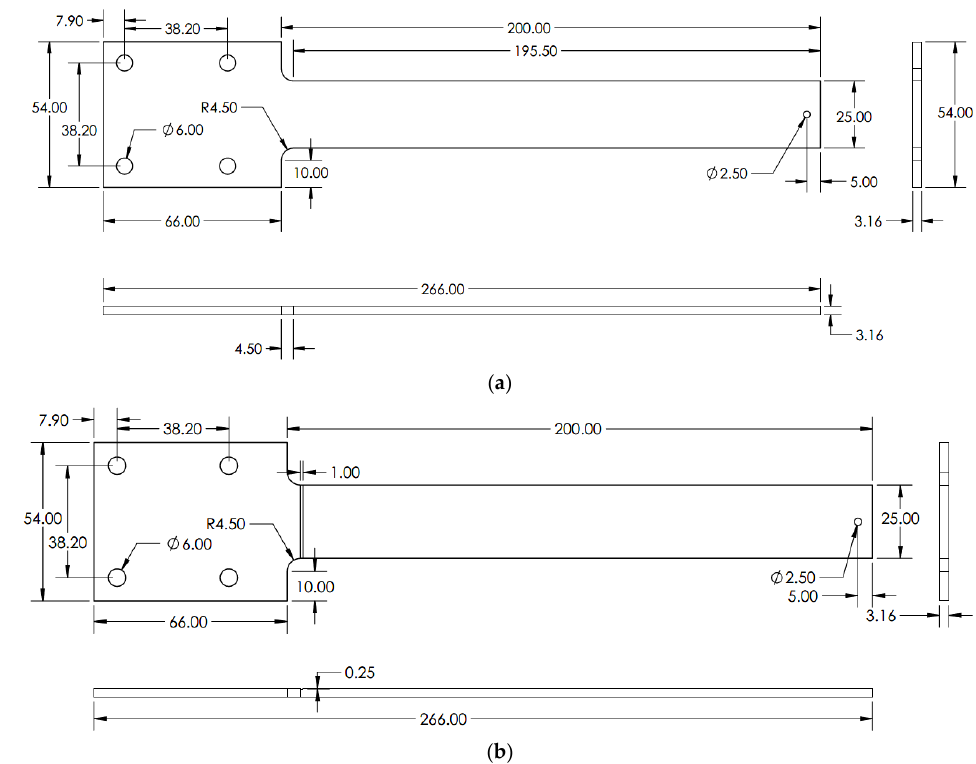
Figure 2. Specimen geometry dimensions in mm ( a ) without crack ( b ) with crack. The specimens were manufactured to have accurate dimensions using a computer numerical control machine. This experimental arrangement was considered to access the modal response of the beam under uniform and non-uniform temperatures at a maximum temperature of 200 °C. The beam response was evaluated at three heating rates, namely 2, 5 and 8 °C/min. The first heating rate was assumed as a slow heating rate, while the others were assumed as moderate and high, respectively. These rates were chosen to test the influence of heating duration on modal parameters. This controlled rate of heating was achieved by using a proportional-integral-derivative (PID) temperature controller manufactured by Omega engineering, Manchester, UK. The detail of the experimental scheme is shown in Figure 3, and the experimental setup is shown in Figure 4. For uniform temperature, the heat was supplied in both heating mats. However, the heat was supplied only at one heating mat for non-uniform temperature, i.e., a linear temperature distribution. Thereby, we were able to achieve the linear temperature distribution across the beam.